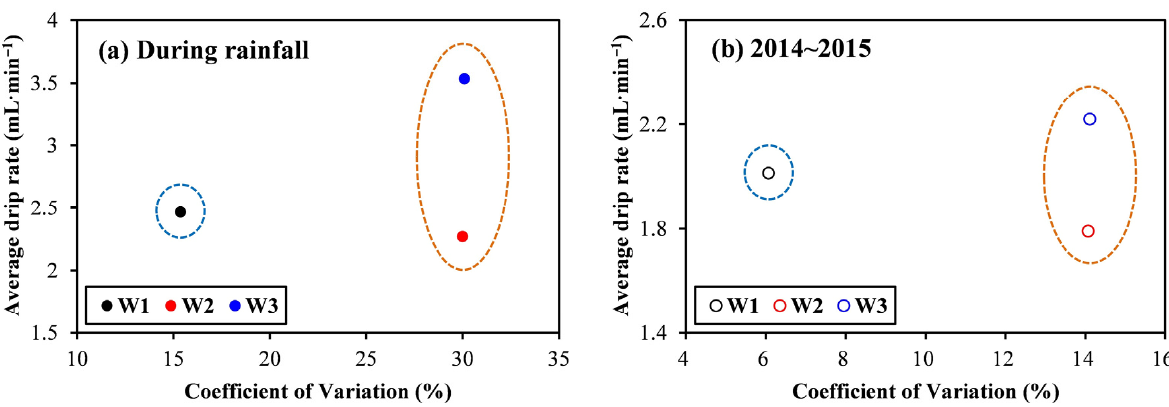
Figure 5. Comparisons between drip rates for the three selected drip sites during this rainfall monitoring ( a ) and the hydrological year from 2014 to 2015 ( b